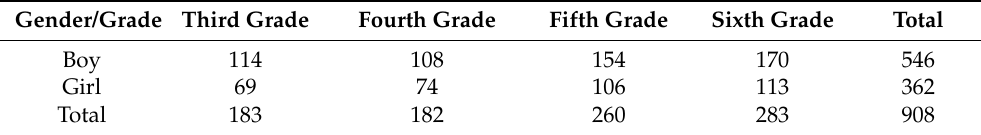
Table 1. The cross table of gender and grade. Gender/Grade Third